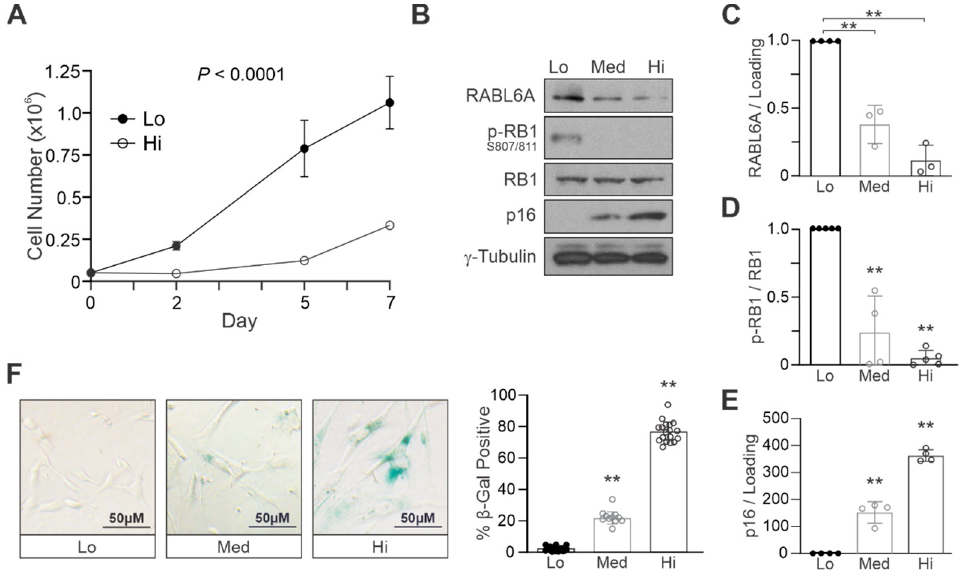
Figure 1. RABL6A expression inversely correlates with markers of cellular senescence in primary NHSCs. ( A ) Low (Lo) versus high (Hi) passage NHSCs were plated at equal density, and cell number was counted on days 2, 5, and 7 after plating. Lo, P2–4; Hi, P8–10. ( B ) Representative Western blot shows RABL6A expression decreases with sequential passaging of NHSCs, which inversely correlates with markers of cellular senescence (reduced phosphorylation of RB1 and induction of p16). Med, medium passage cells (P5–7). ImageJ quantification of western data from three of more experiments showing ( C ) reduced RABL6A expression, ( D ) reduced phopho-RB1 S807/811, and ( E ) increased p16 expression in Lo, medium (Med), and Hi passage NHSCs. ( F ) Left, representative bright field images of β -galactosidase staining, showing an increase in senescent cells upon sequential passaging (Lo, Med and Hi). Right, quantification from three or more experiments, each performed in duplicate. Each dot represents a minimum of 150 cell counts per well. ( A ) p value determined by a generalized linear model to assess the difference between the curves. Error bars, SD from mean. ( C – F ) p value, One-way ANOVA with Dunnett’s correction. (**, p < 0.001).